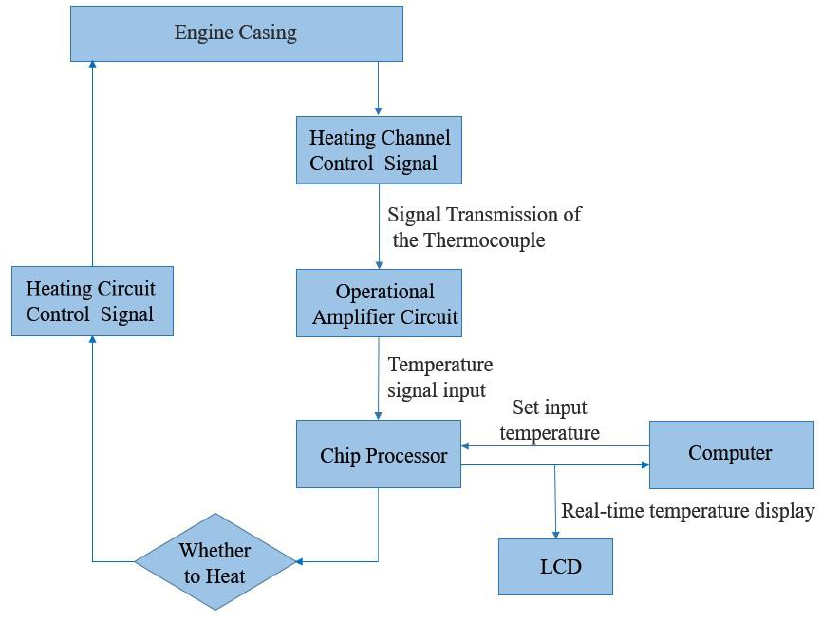
Figure 8. The temperature control logic.